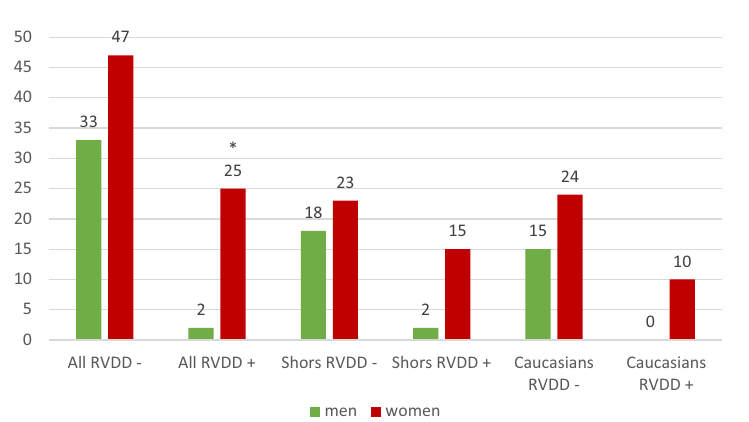
Figure 2. The right ventricle diastolic dysfunction frequency in the study groups. RVDD – right ventricular diastolic dysfunction; *p < 0.05 compared with men